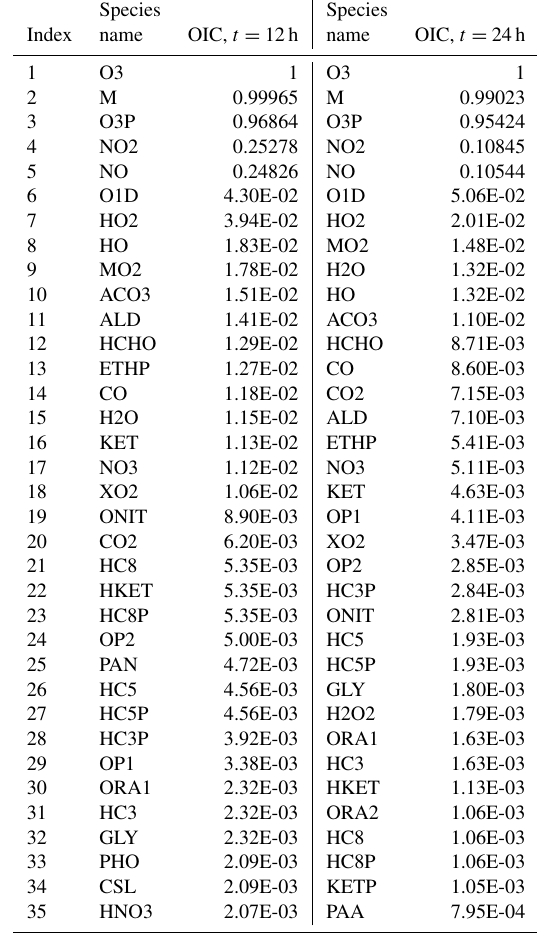
Table 2. Overall interaction coefficients (OICs) for target O 3 (top 35) for case A at t = 12 and t =